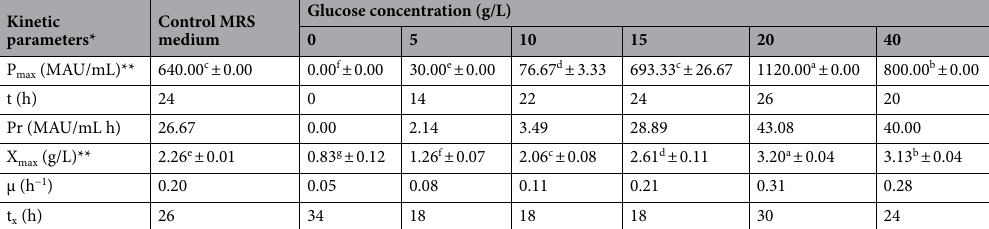
error of the mean (SEM), n = 3. Mean ± SEM within the same column that does not share a similar superscript are significantly different (p <